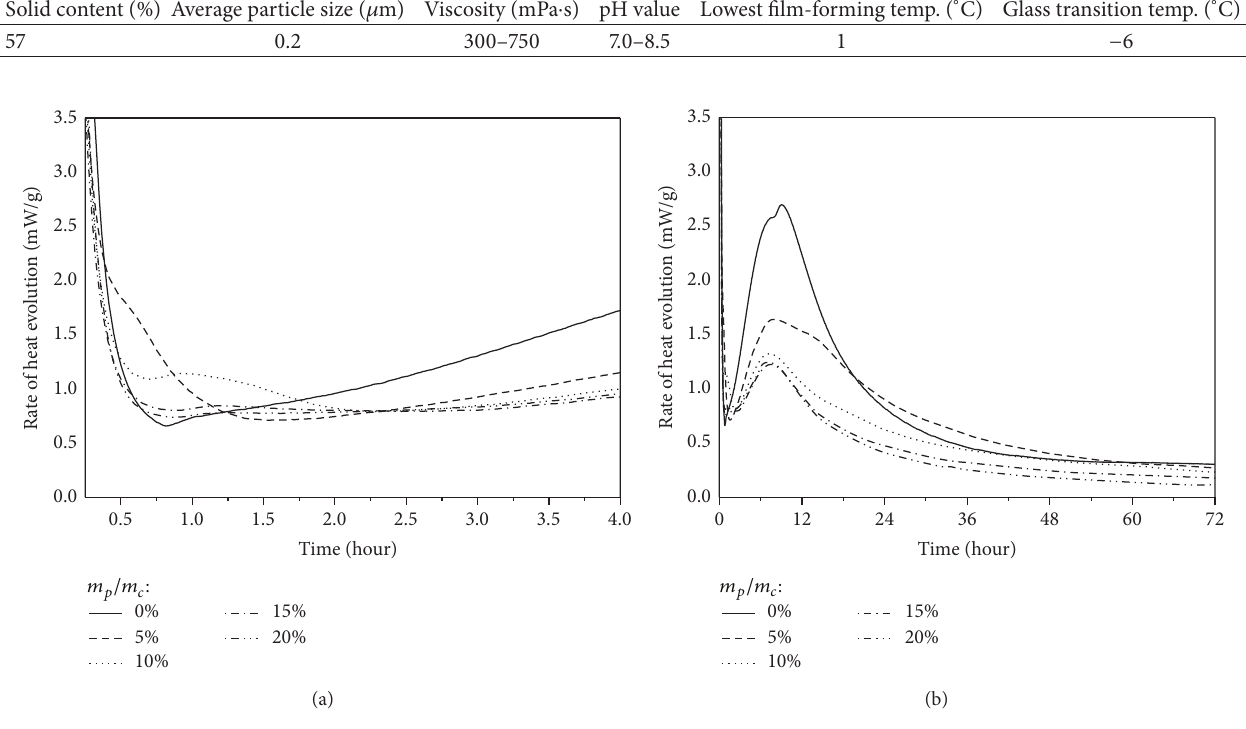
Table 3: Properties of styrene-acrylic (SAE) dispersion.